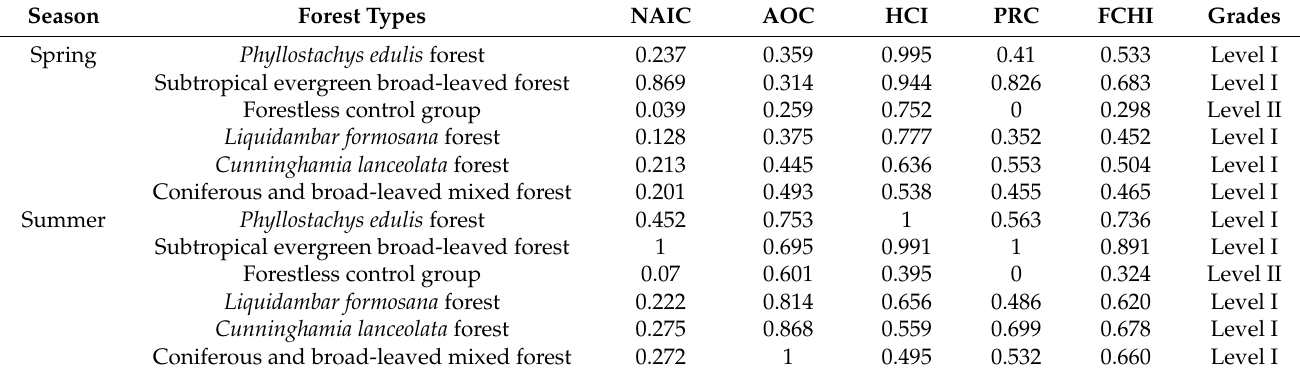
Table 8. Normalized value of indicators and comprehensive healthcare benefits